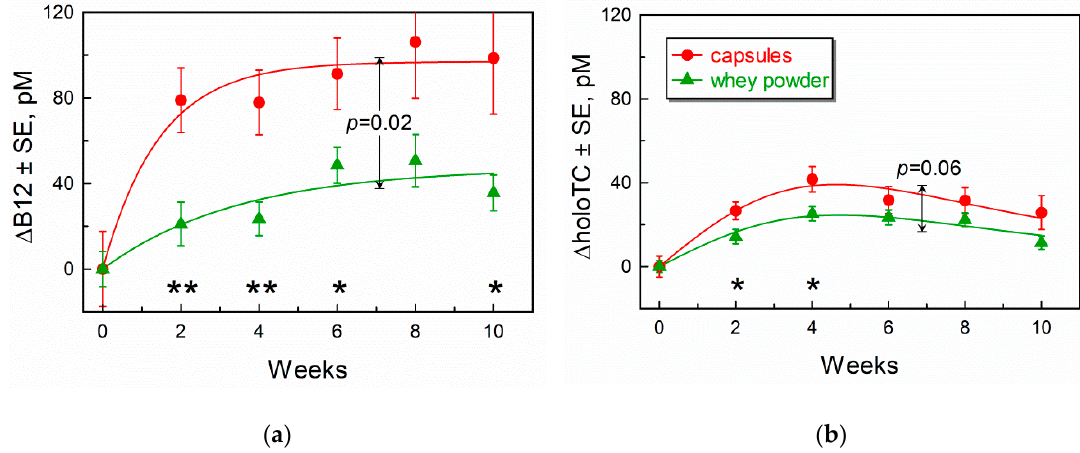
Figure 2. Time-dependent increase (as compared to baseline values) in ( a ) total plasma B12, fitted by Equation (1), and ( b ) holoTC, fitted by Equation (2), after supplementation of CN-B12 in capsules ( ● , red) or HO-B12 in whey powder ( ▲ , green). The data are presented as mean values ± SEM. Symbols (*) and (**) indicate significant differences between the two datasets at particular time points according to t -test ( p < 0.05 and 0.01, respectively). The arrows with stop-lines and accompanying p -values show the overall difference between the fitting curves for the two treatments.